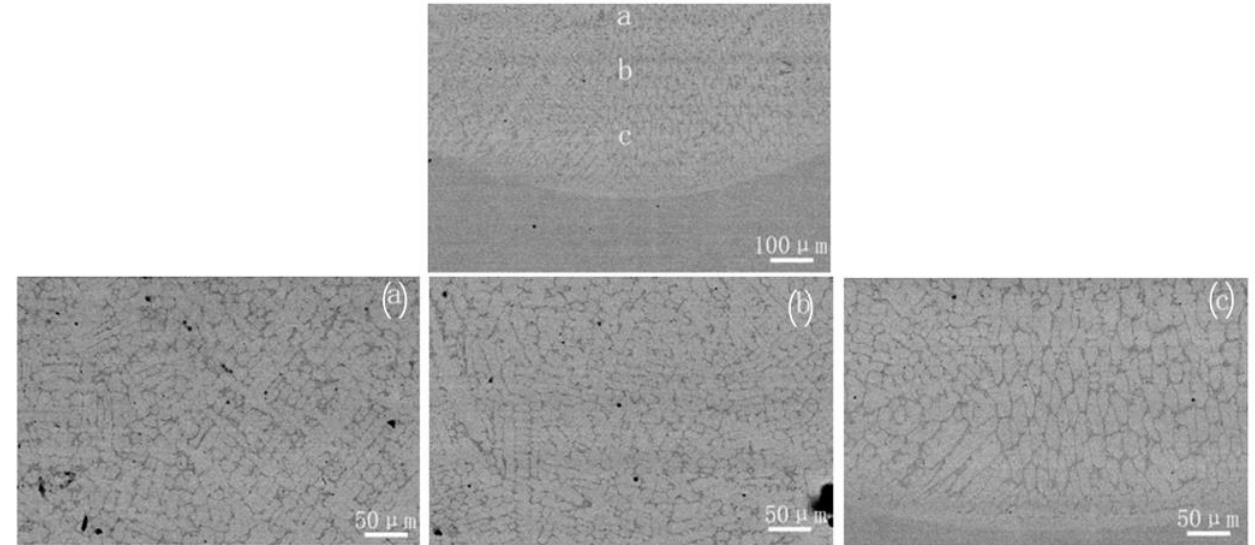
Figure 10. Molten pool structure morphology. ( a ) Top area of the molten pool; ( b ) Middle area of the molten pool; ( c )The bottom area of the molten pool.